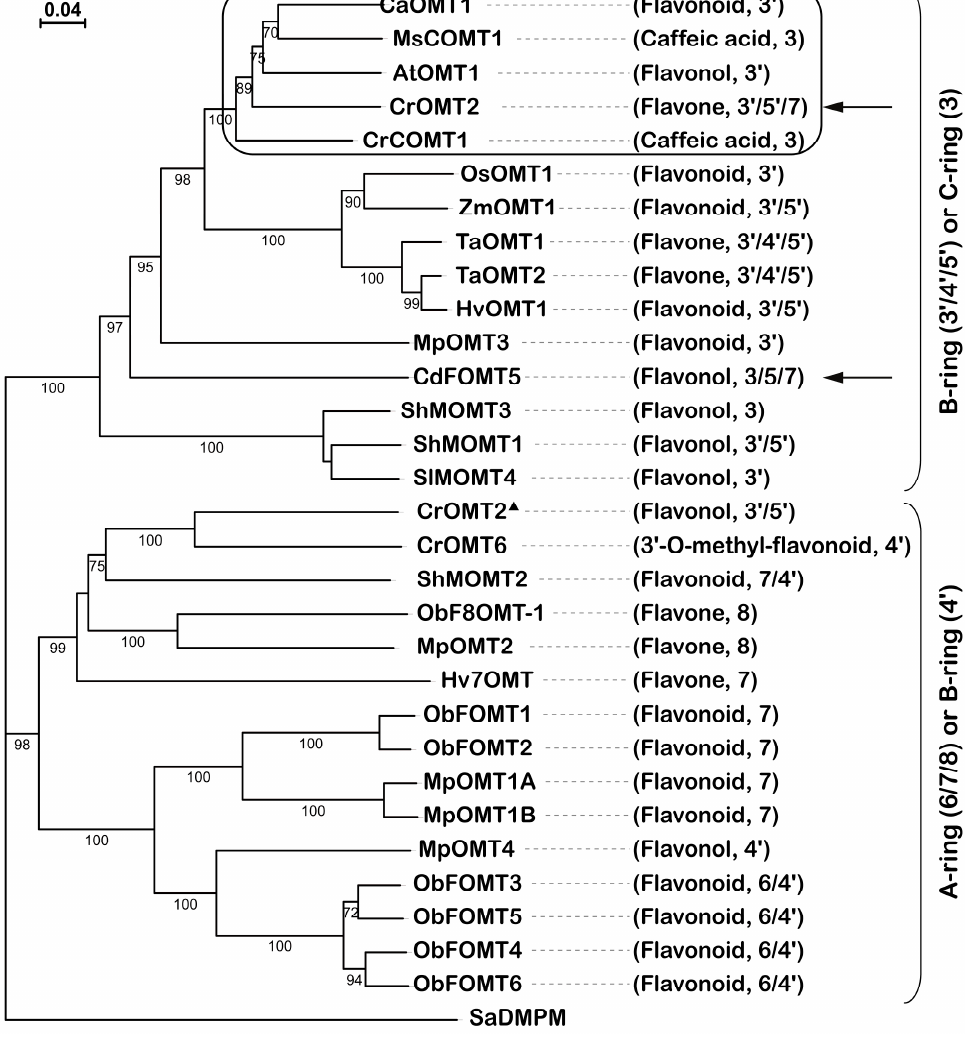
Figure 5. Phylogenetic tree of Citrus reticulata O -methyltransferase 2 (CrOMT2) and selected plant caffeic acid O -methyltransferases (COMTs) at the protein level. The preferred substrates and methylation positions are indicated for each protein. Percent bootstrap values (n = 1000) greater than 70 are shown in the middle of each branch. The evolutionary history was analyzed using the neighbor-joining method with SaDMPM from Streptomyces alboniger acting as the outgroup. Two COMTs from citrus are indicated with arrows. The small clade including CrOMT2 from C. reticulata is boxed in black. To avoid ambiguity, CrOMT2 from Catharanthus roseus was marked with a triangle. See Supplementary Table S3 for UniProt entries and species of the OMTs.